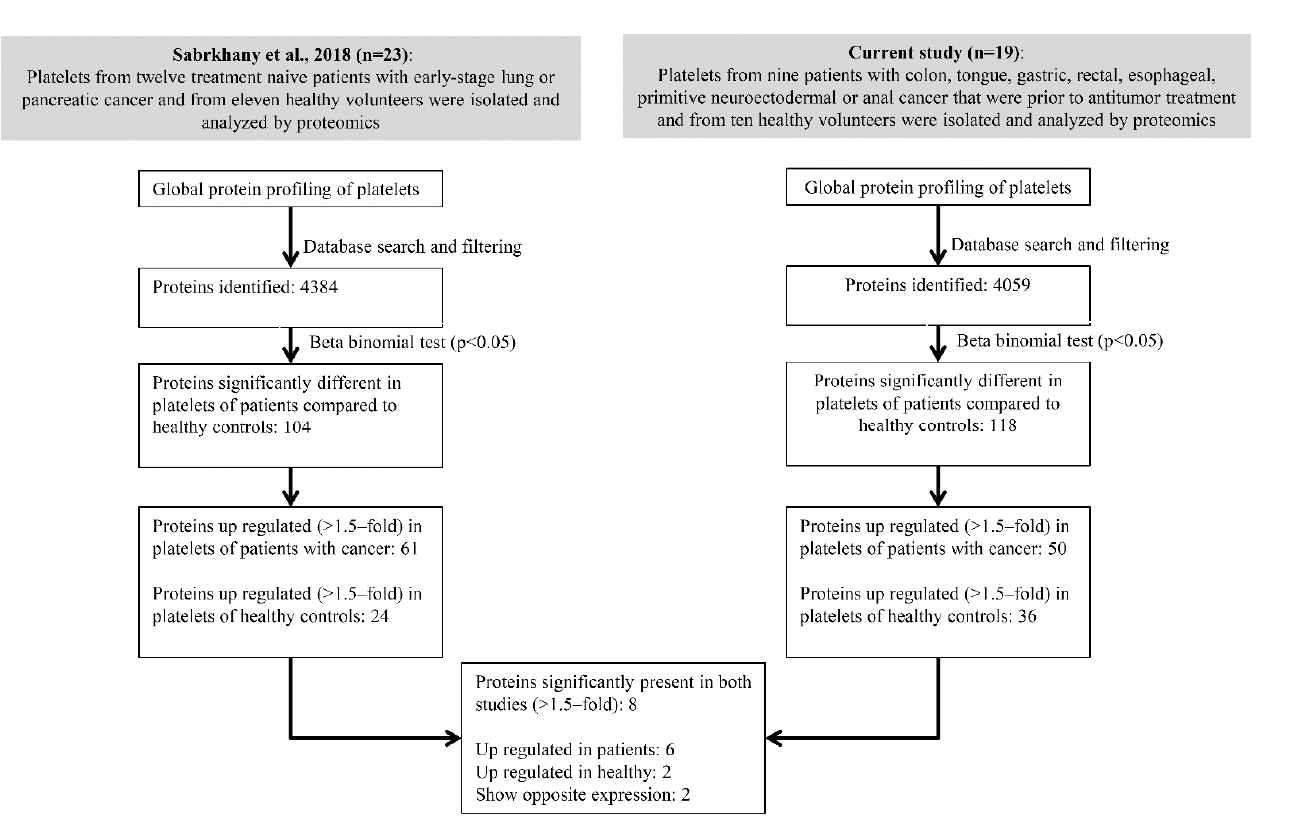
Figure 6. Flowchart depicting the steps used to select the most promising cancer-associated proteins within platelets, of which eight overlapped with our previous cancer platelet proteomics study [28]. Table 2. List of cancer associated proteins in platelets.